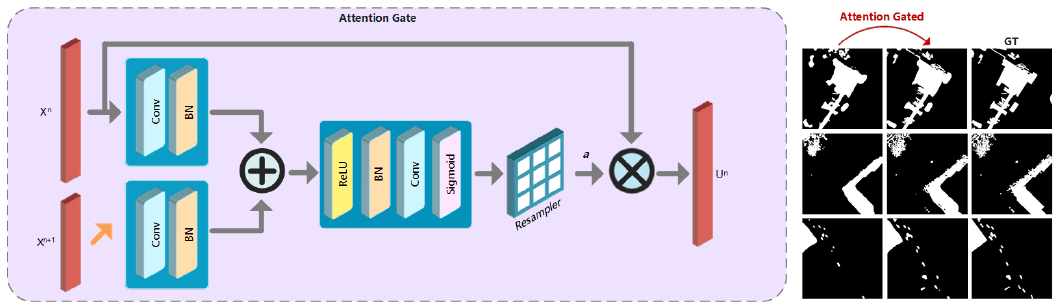
Figure 2. Illustration of attention gate (AG) architecture. The inputs to AG are feature maps from different stages, X n + 1 and X n . The output of is U n = X n · a , where a is the attention coefficients and · refers to element-wise multiplication. The attention gated change maps are closer to the ground truths